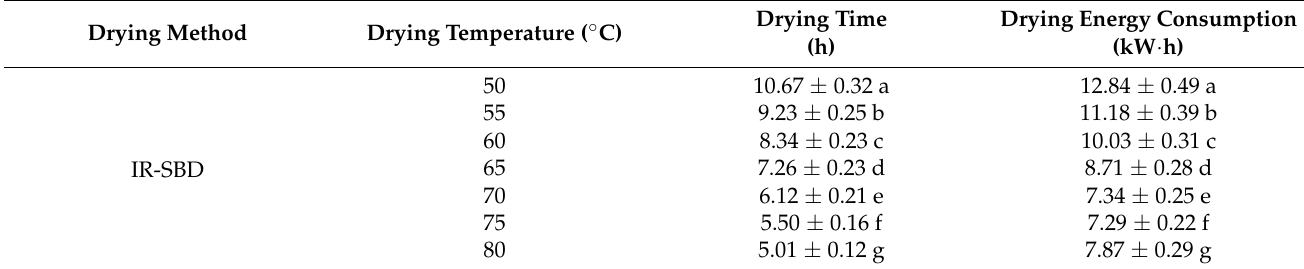
Values expressed as mean ± standard error ( n = 3); different letters in each column indicate a significant difference at p ≤ 0.05